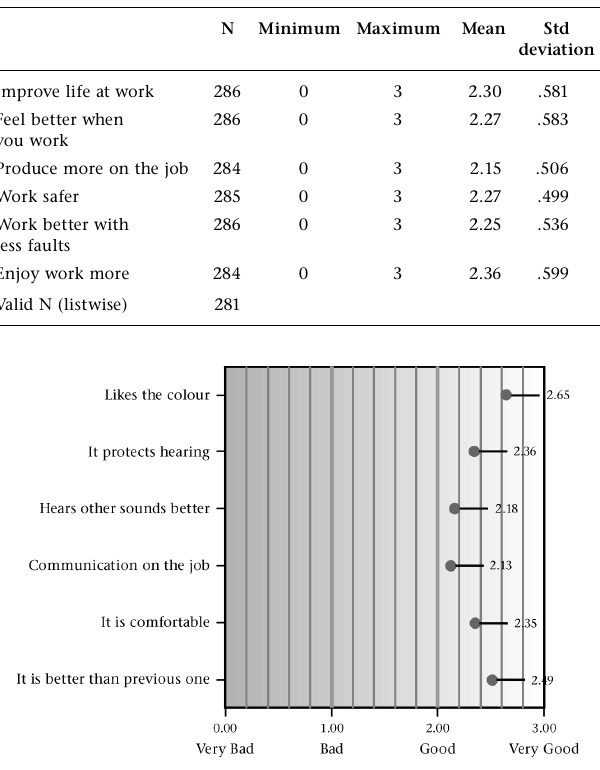
Figure 2: Means of the items pertaining to what respondents